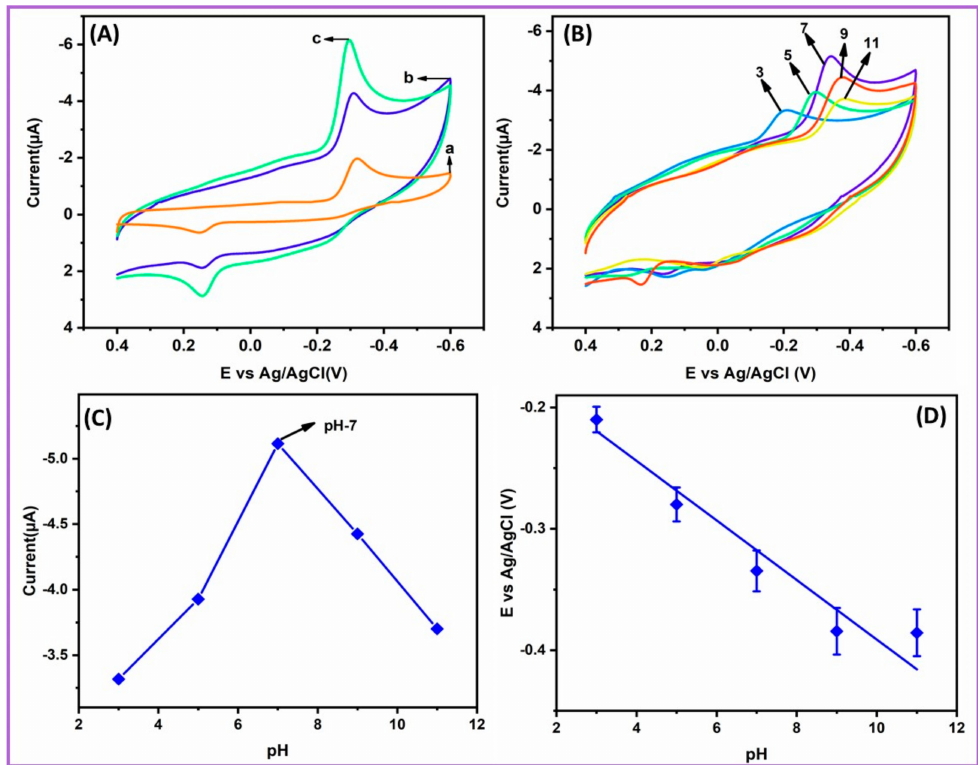
Figure 5. ( A )—( a ) CV’s of unmodified glass carbon electrode (GCE), ( b ) NiCo 2 O 4 -MFs / GCE, and ( c